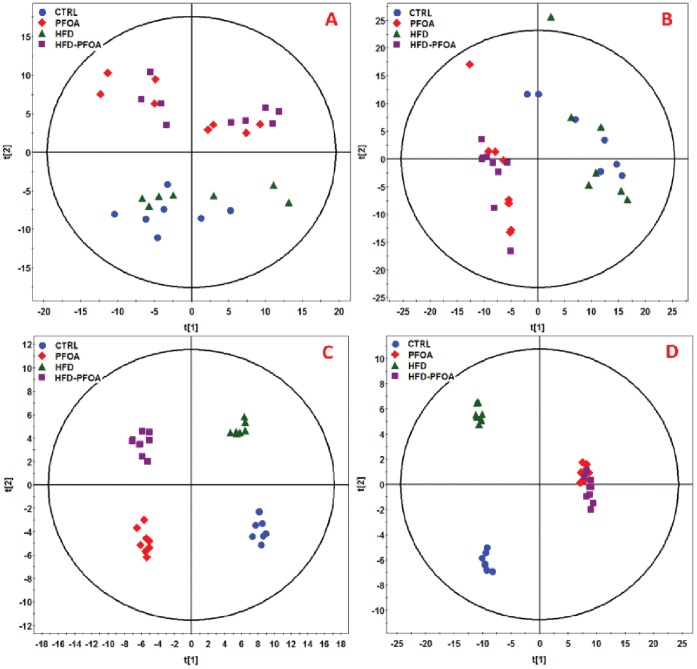
PCA and OPLS-DA scores plots of spectral data of serum and liver metabolites in mice fed HFD or/and PFOA.Adult mice were pair-fed a high-fat diet (HFD) or low fat control diet (CTRL) with or without perfluorooctanoic acid (PFOA) administration at 5 mg/kg/day for 3 weeks. Metabolite profiles of serum and liver tissue homogenates were analyzed by GC-TOFMS and HPLC-TOFMS (n = 7–8). A. PCA score plot of serum metabolites. B. OPLS-DA score plot of serum metabolites. C. PCA score plot of hepatic metabolites. D. OPLS-DA score plot of hepatic metabolites.